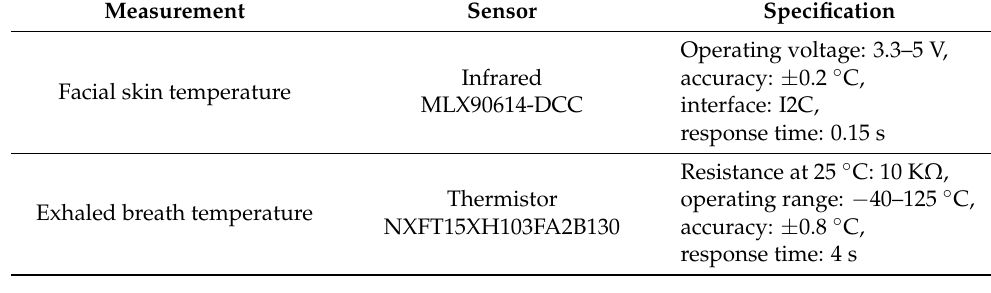
Table 1. Details of the sensors used for this study. Measurement